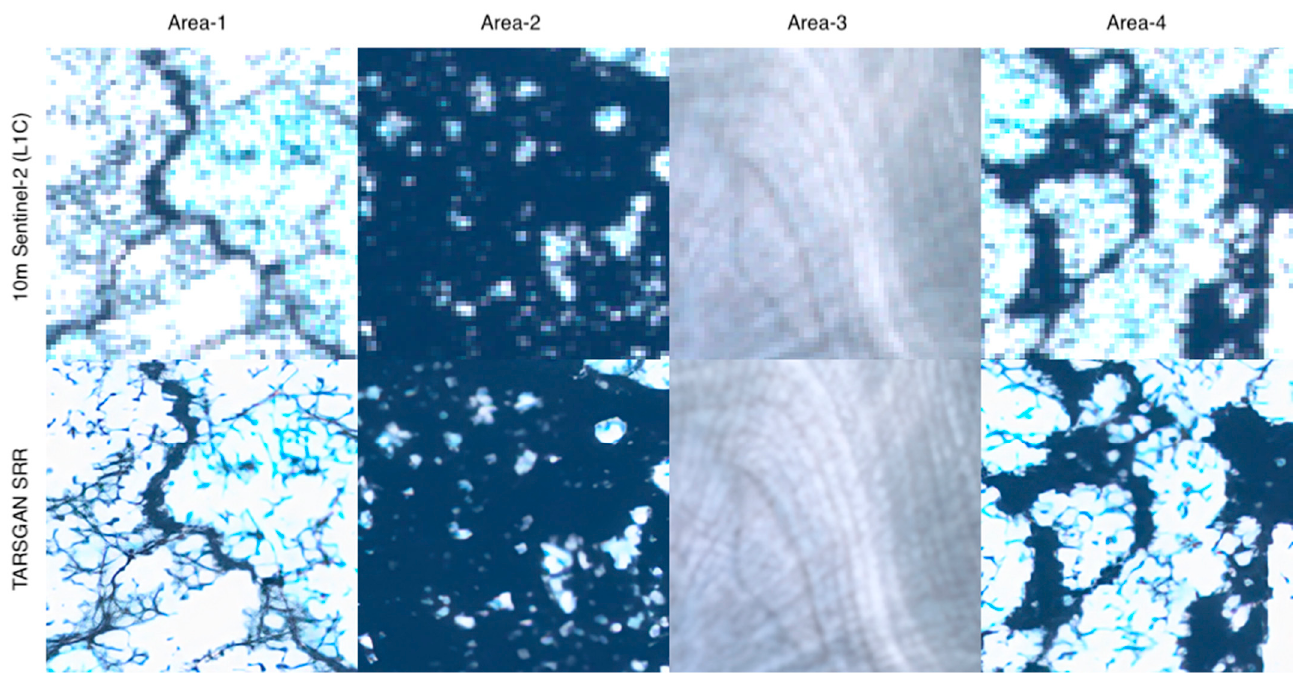
Figure 14. Cropped examples (625 m × 625 m) of the 10 m/pixel Sentinel-2 “true” colour images (L1C) and TARSGAN SRR result over Lincoln Sea, Greenland (Site-6). Please refer to Supplementary Material for full-size SRR (produced from